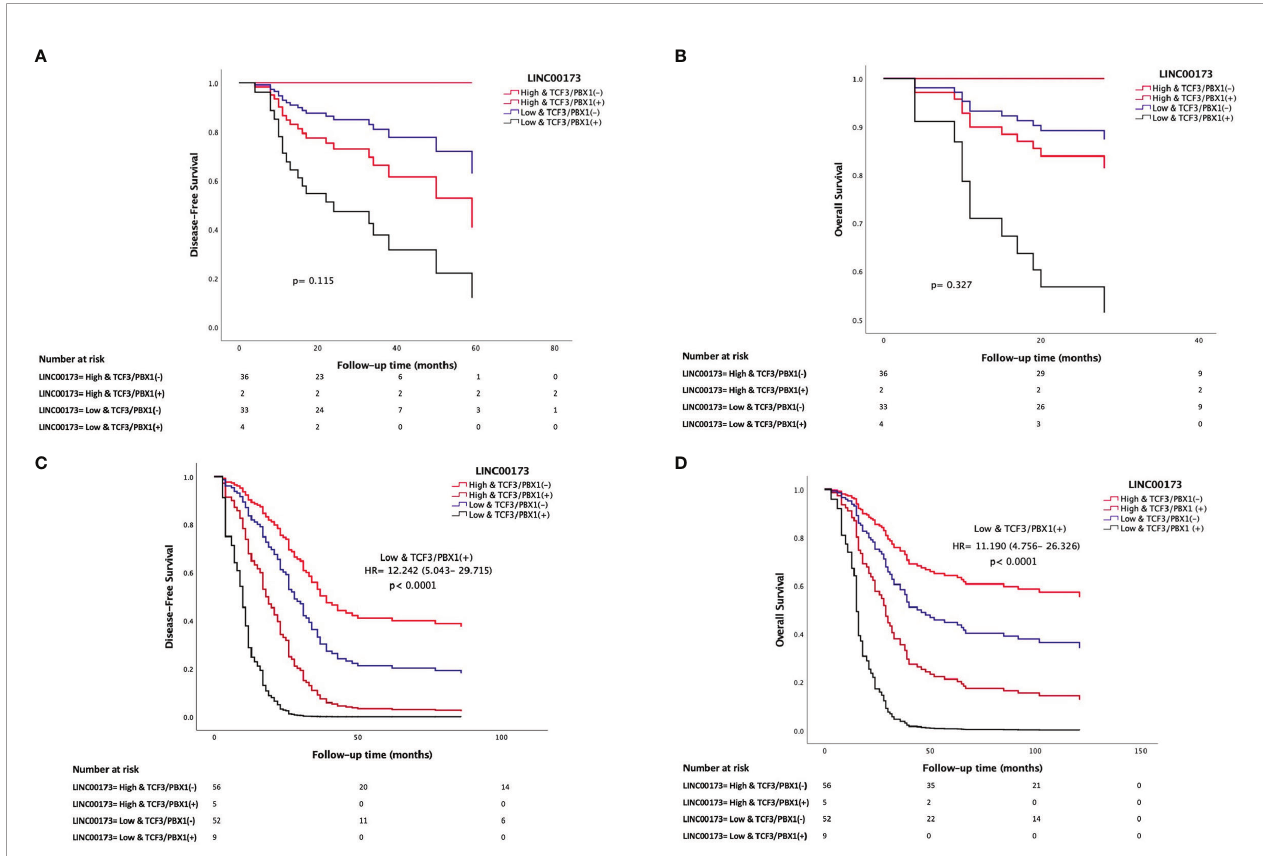
FIGURE 5 | LINC00173 underexpression with TCF3/PBX1 expression in B-cell precursor acute lymphoblastic leukemia patients has the worst prognosis. Cox regression analysis of disease-free survival (A) and overall survival (B) in Mexican patients and the TARGET cohort (C, D) . Patients from the TARGET cohort having underexpression of LINC00173 and TCF3/PBX1 expression have the worst risk to relapse (C) and die (D)